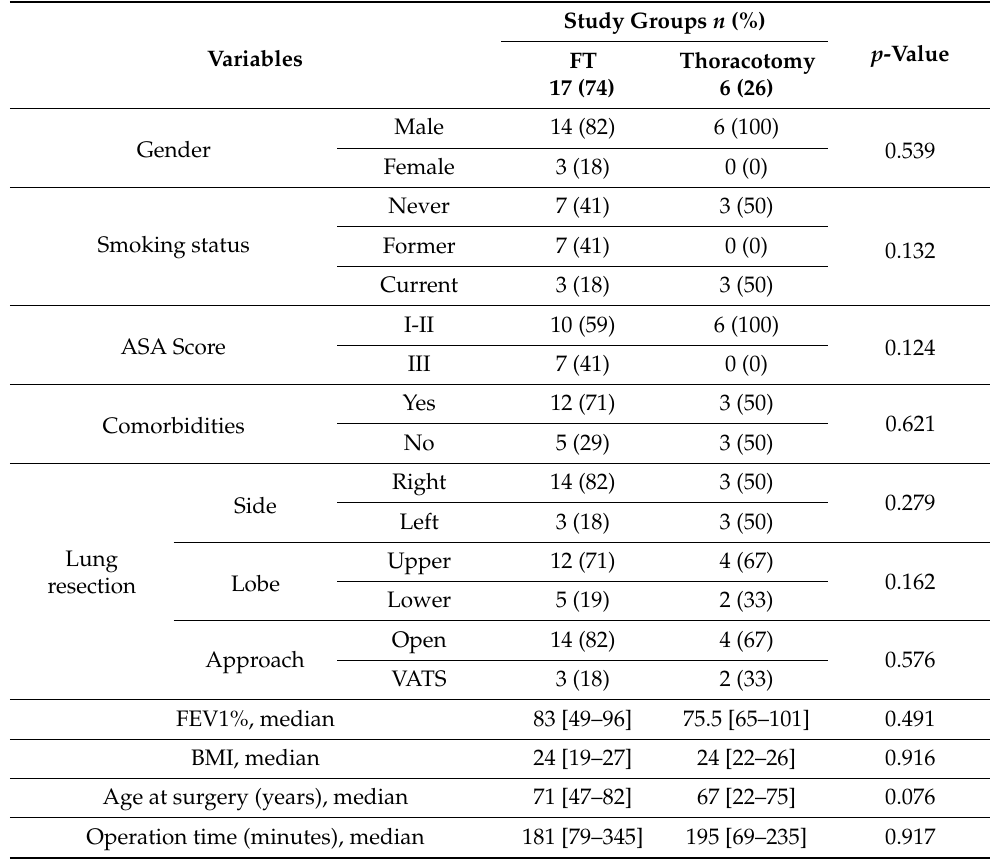
Table 2. Comparison of baseline characteristics between groups ( n = sample size, % = percentages, [] = ranges).